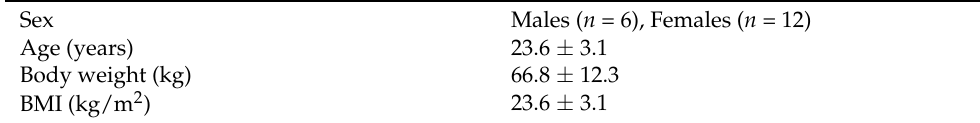
Table 1. Baseline participant